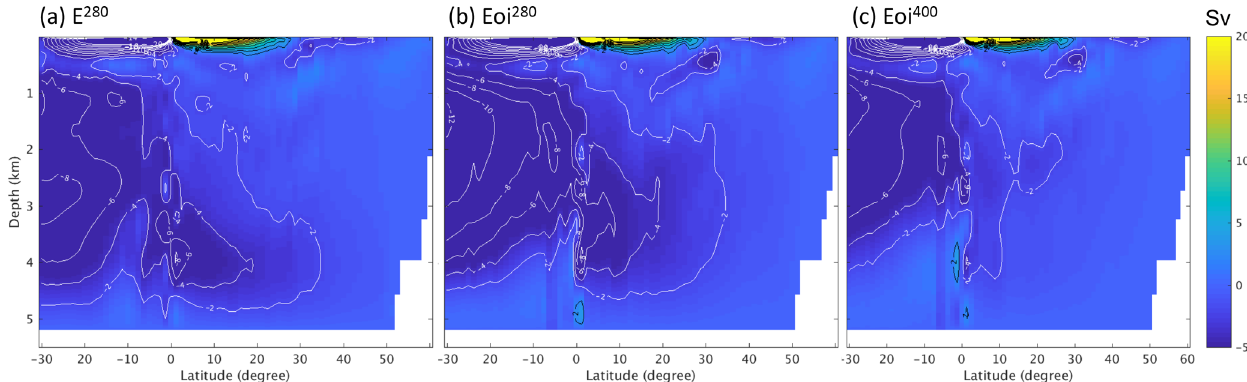
Figure 13. Time-averaged Pacific overturning circulation for (a) E 280 , (b) Eoi 280 and (c) Eoi 400 . Positive values indicate clockwise circu- lation.